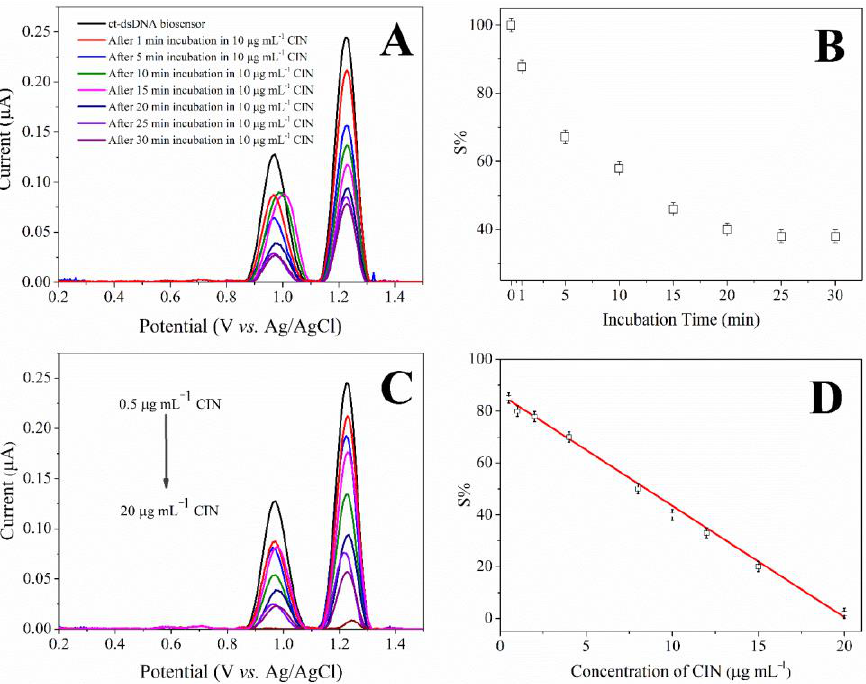
Figure 3. ( A ) DP voltammograms and ( B ) the plot of the current of the dAdo peak vs. incubation time for the interaction of ct- dsDNA biosensor with 10 μg mL −1 CIN, ( C ) DP voltammograms of the ct-dsDNA biosensor after interacting with various CIN concentrations, ( D ) Calibration plot for CIN determination based on the current of the dAdo peak.